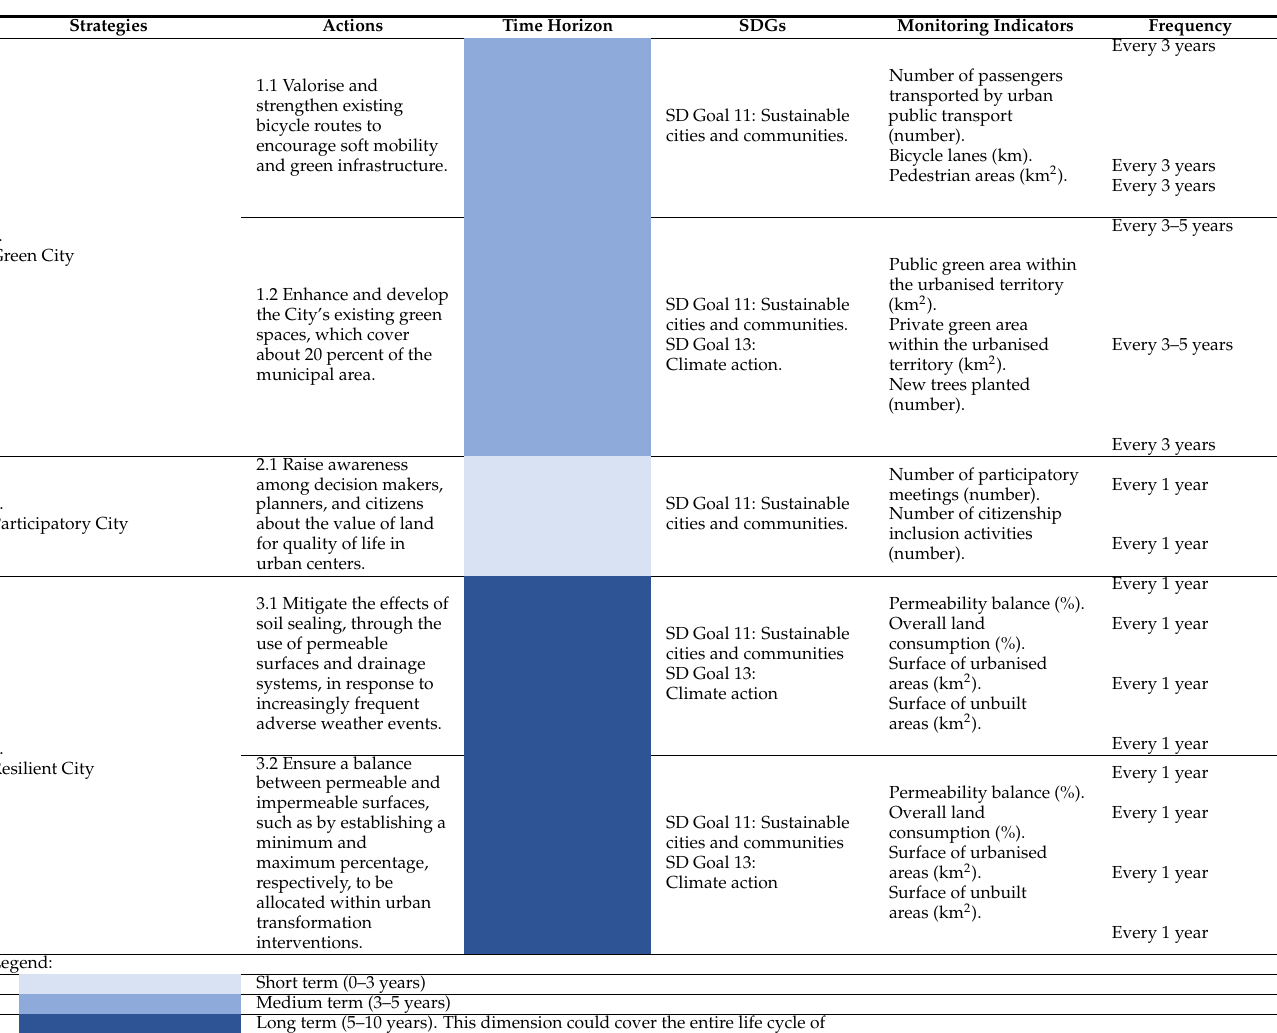
Table 18. Guidelines for the General Regulatory Plan of the City of Turin